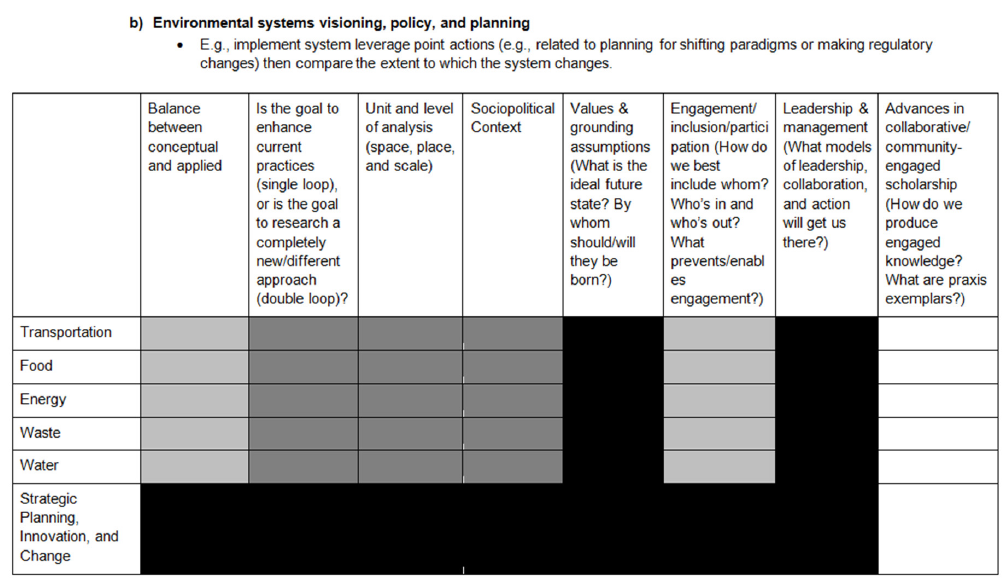
Figure 1. Framework tool for theme (b) Environmental systems visioning, policy, and planning. Darkest cells represent intersecting research foci with most potential (see text above for further explanation).